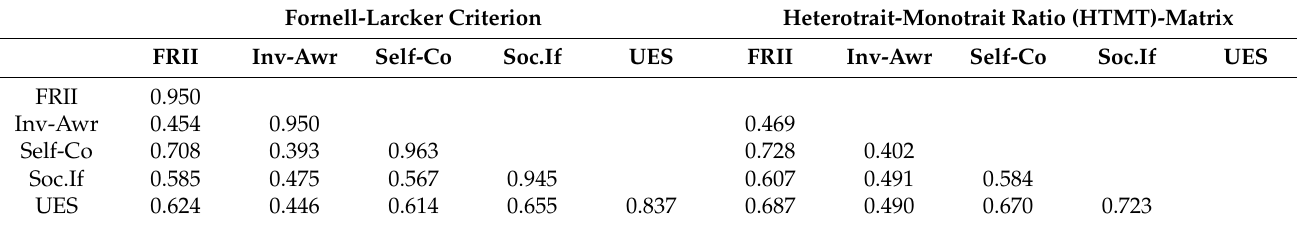
Table 3. Discriminant validity results.